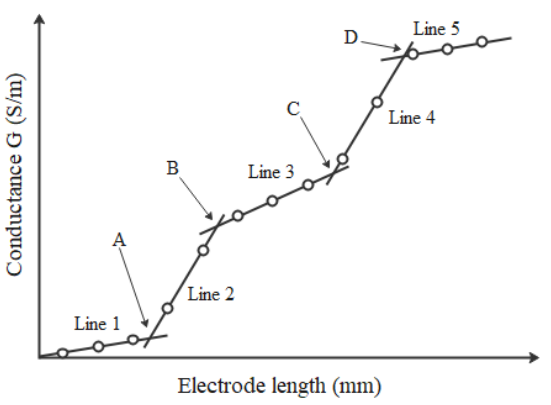
Figure 4. Linear piecewise relationship between conductance and increasing length.